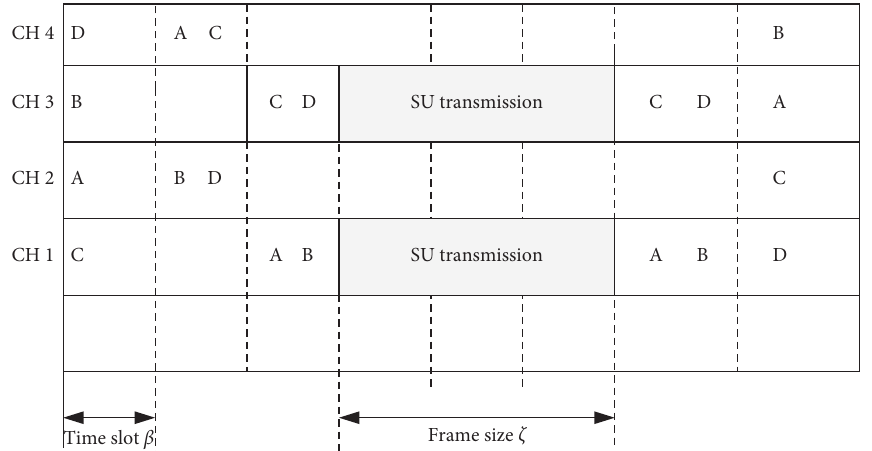
Figure 8: An example of the channel switching events by proposed protocol.